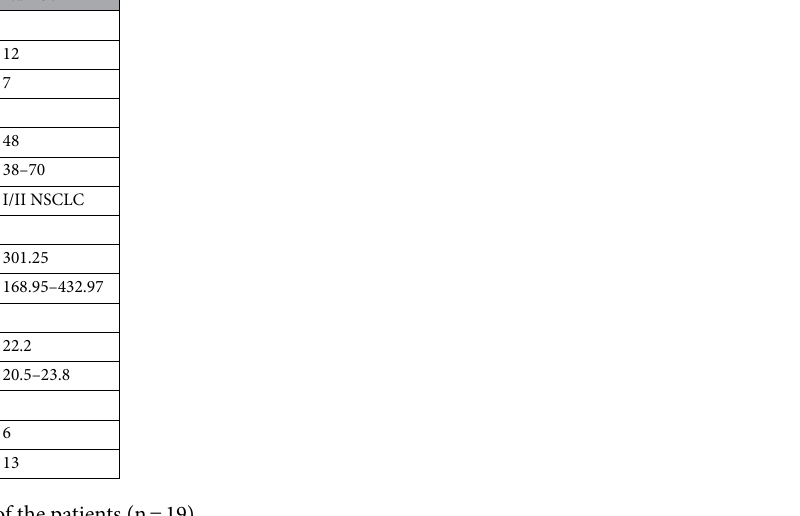
Table 1. Characteristics of the patients (n =